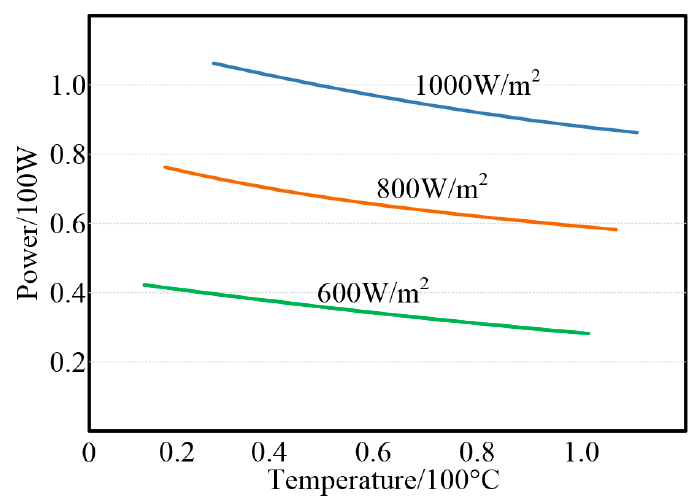
Figure 2. Characteristics of the PV cell at different environmental conditions: ( a ) Different solar radiation level effect; ( b ) different temperature variability effect.